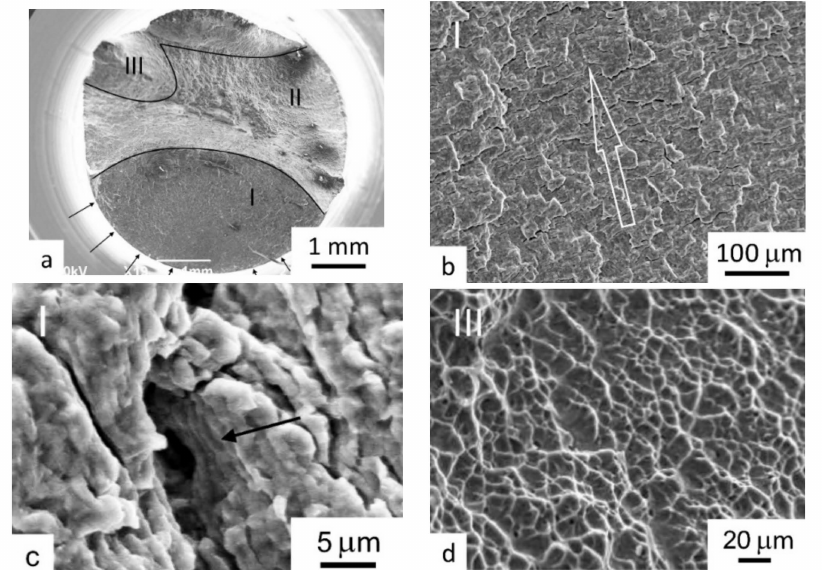
Figure 11. SEM images of the fracture surfaces of the UFG alloy samples after tests at a stress of 750 MPa: ( a ) general view of the fracture surface (the black arrows show the origins); ( b ) zone of stable crack propagation (zone I), white arrow shows the direction of growth of the main crack; ( c ) fatigue striations in zone I (arrow); ( d ) dimple relief of final rupture